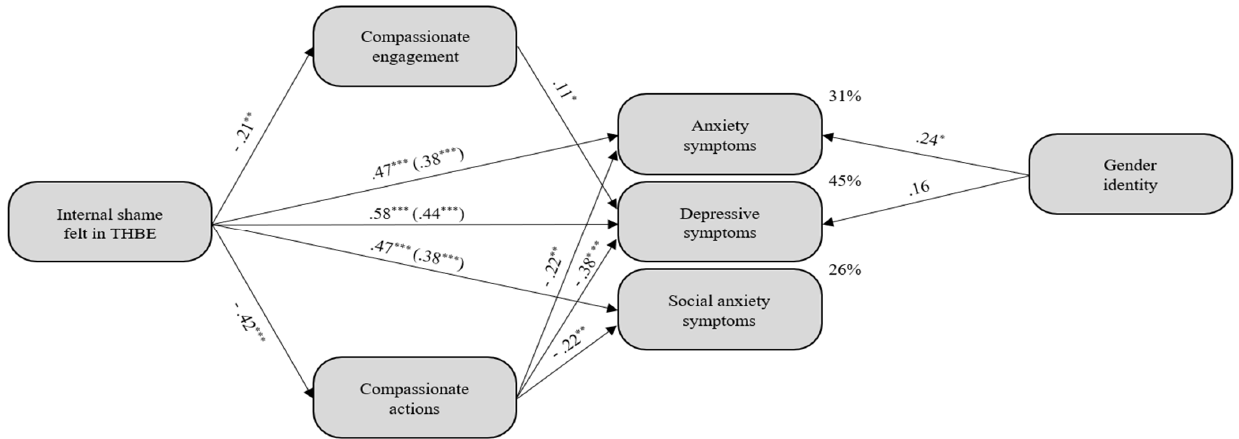
Figure 2. The mediation effect of engagement and actions in the relationship between internal shame felt in traumatic homophobic experience and anxiety, depression, and social anxiety symptoms. Standardized path coefficients among variables are presented (n = 186). This figure is simplified. The mediators and dependent variables have associated errors that are not presented. * p < .05; ** p < .005; *** p <